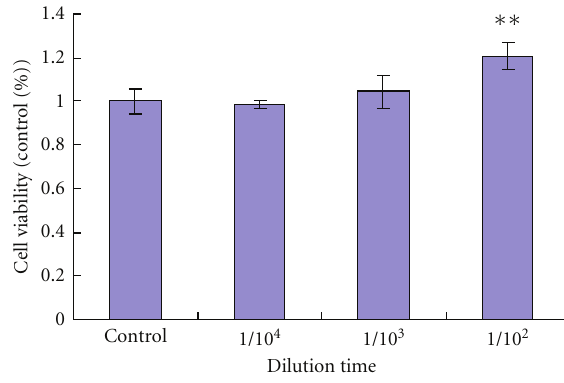
Figure 3: E ff ect of C. monspeliensis extract on the cell viability by Caco-2 cells. Caco-2 cells were treated with 0.1% to 0.001% (w/v) of C. monspeliensis extract for 24h. Each bar represents the mean ± SD ( n = 3). ∗ P < 0 . 05, ∗∗ P < 0 . 01 compared to the control as determined by the t